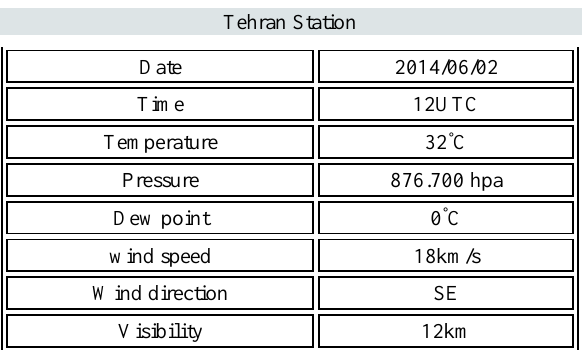
Table 2. Tehran (Mehrabad) synoptic weather station data.